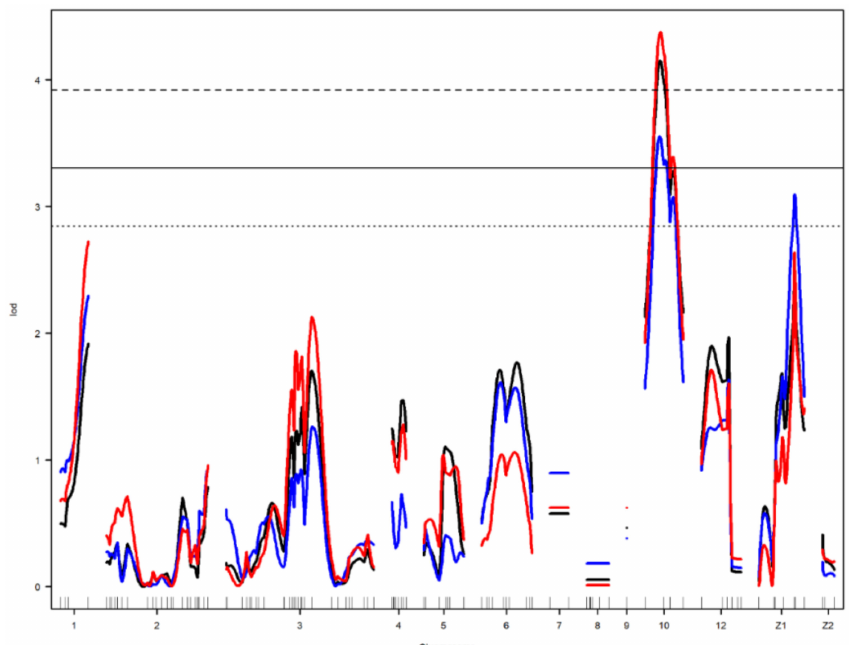
Figure 4. Genome-wide LOD plot of detected QTL for egg weight 1 (black) and albumen weight 1 (red) on chromosome 10, and egg short axis 1 (blue) on chromosomes 10 and Z1. The horizontal lines show the genome-wide significance threshold at 1% (dashed line) and 5% (straight line) and suggestive threshold at 10% (dotted line) levels.